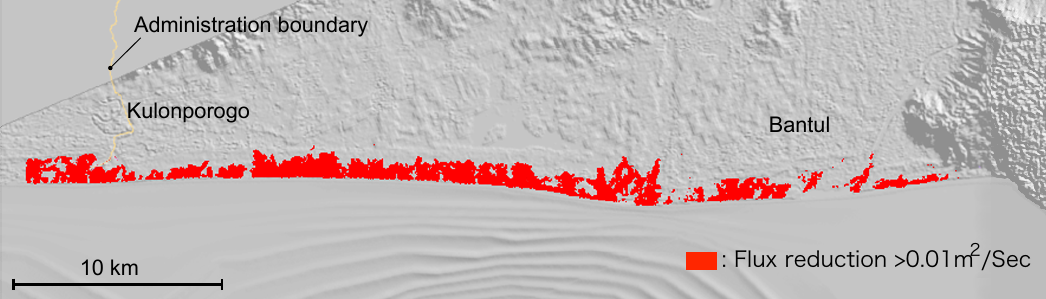
Fig. 12. The area of influence on inundation flux with the trees in 2006